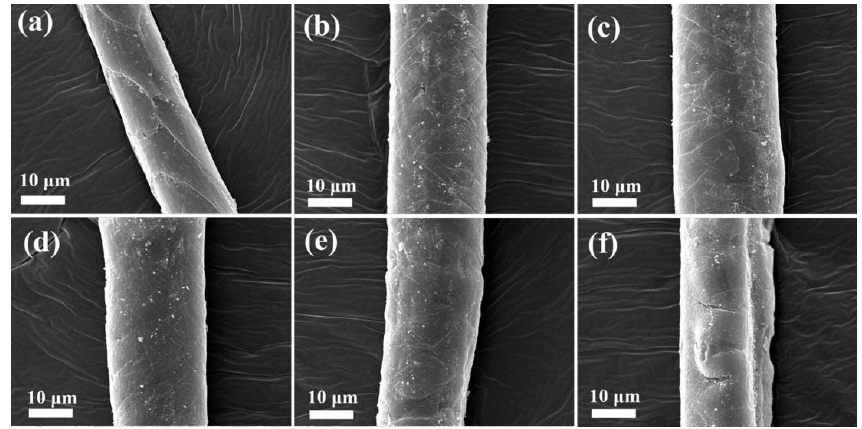
Figure 14. SEM images of bleached camel hair with different contents of ethanol during oxidative